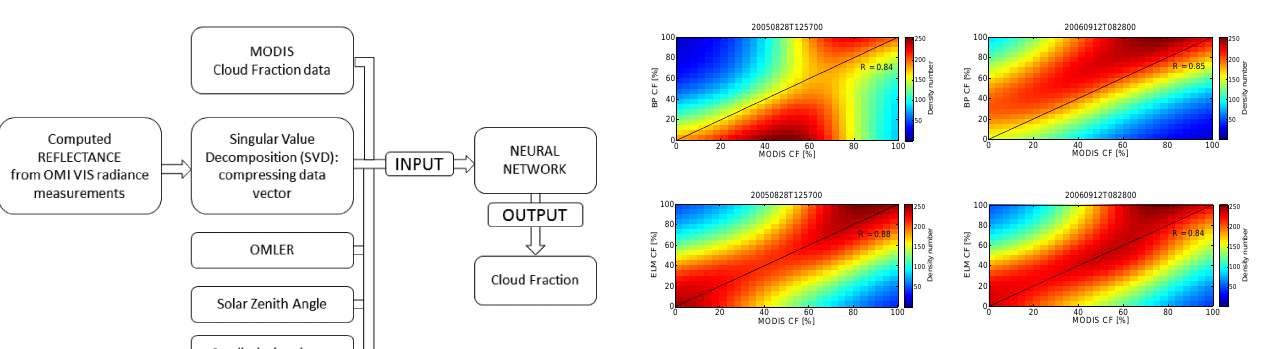
Fig. 4. Density plots showing the correlation between the cloud fraction estimated by the neural networks used in this study and MODIS data over ocean. Correlation coefficients ( R ) are shown in each plot.